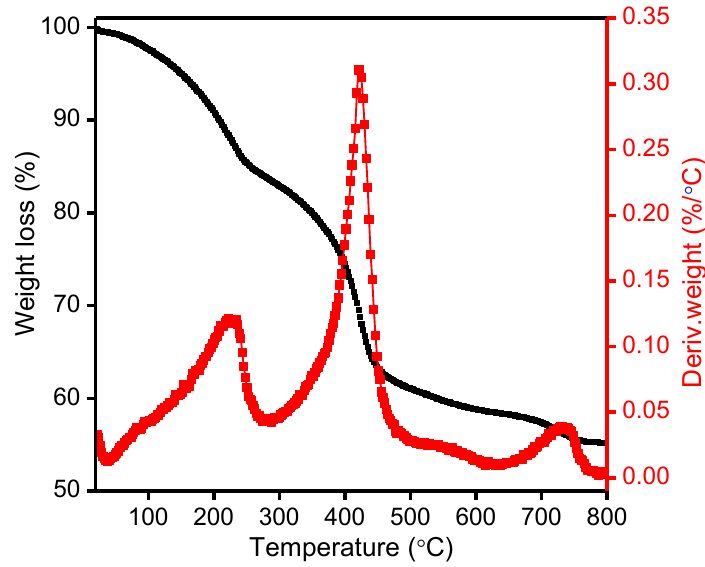
Figure 2. TG-DTG profile of synthesized Mg-Ca-Al-LDH material.